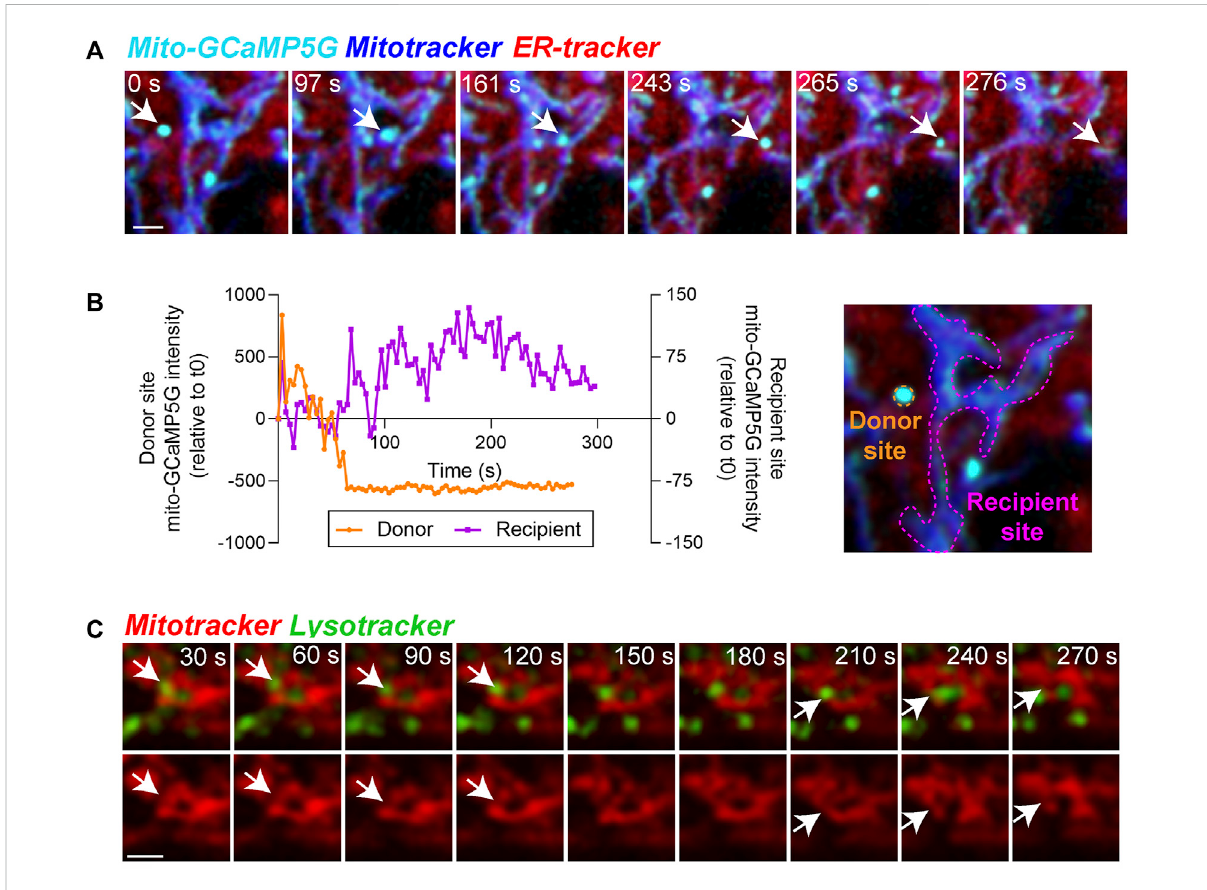
FIGURE 4 Functional relevance of mitochondria-ER and mitochondria-lysosome contacts in the RPE. (A) Stills from live imaging of interactions between mitochondrial calcium (mito-GCaMP5G, cyan), ER-tracker (red), and Mitotracker deep red (blue) in primary RPE monolayers showing heterogeneity of mitochondrial calcium within the cell. Arrow indicates one calcium transfer event. Note ER-mediated transfer of calcium to mitochondria in frames243sand265 s.ImagesweredeconvolvedusingNikonNIS-Elements.Scalebar=1 µM.AlsoseeSupplementaryMoviesS4. (B) Changes inmeanintensity ofmito-GCaMP5Gontheindicateddonorandrecipientsites. (C) StillsfromliveimagingofcontactsbetweenMitotracker(red)and Lysotracker (green). Top panel shows merged view, bottom panel shows Mitotracker signal only. Arrows indicate mitochondrial fi ssion events. Images were deconvolved using Nikon NIS-Elements. Scale bar = 1 µM. Also see Supplementary Movies